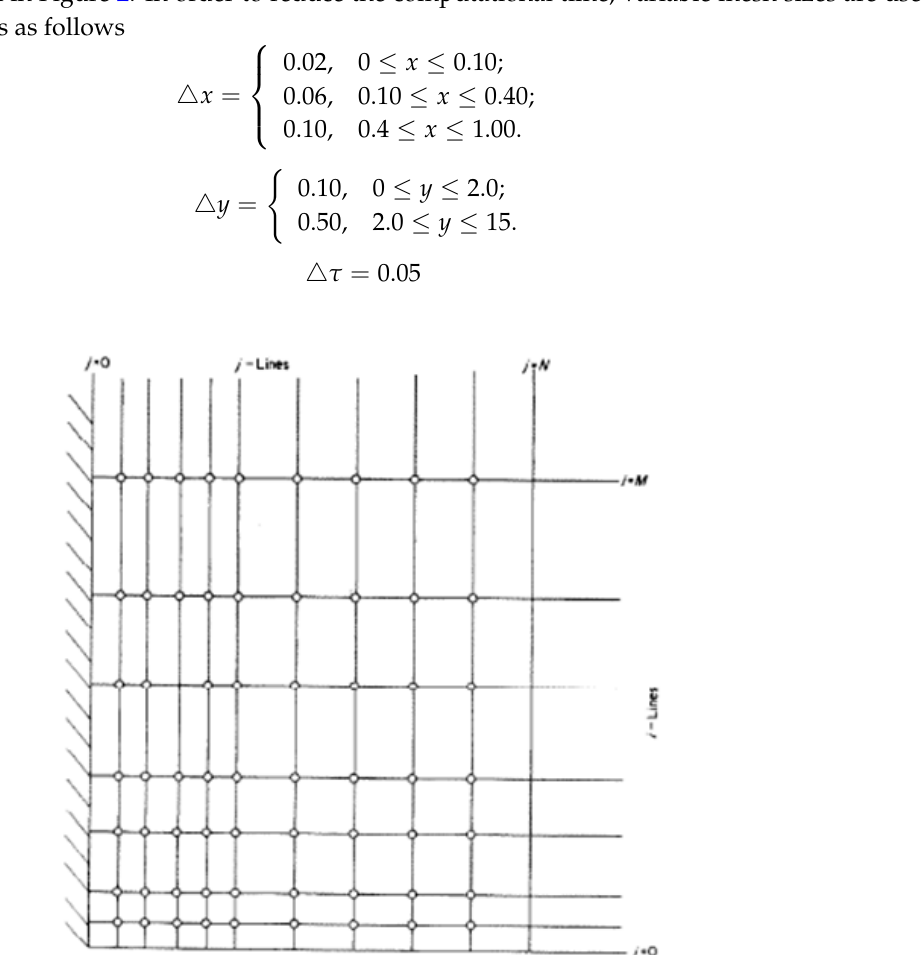
Figure 2. The finite difference space grid for a non-uniform grid